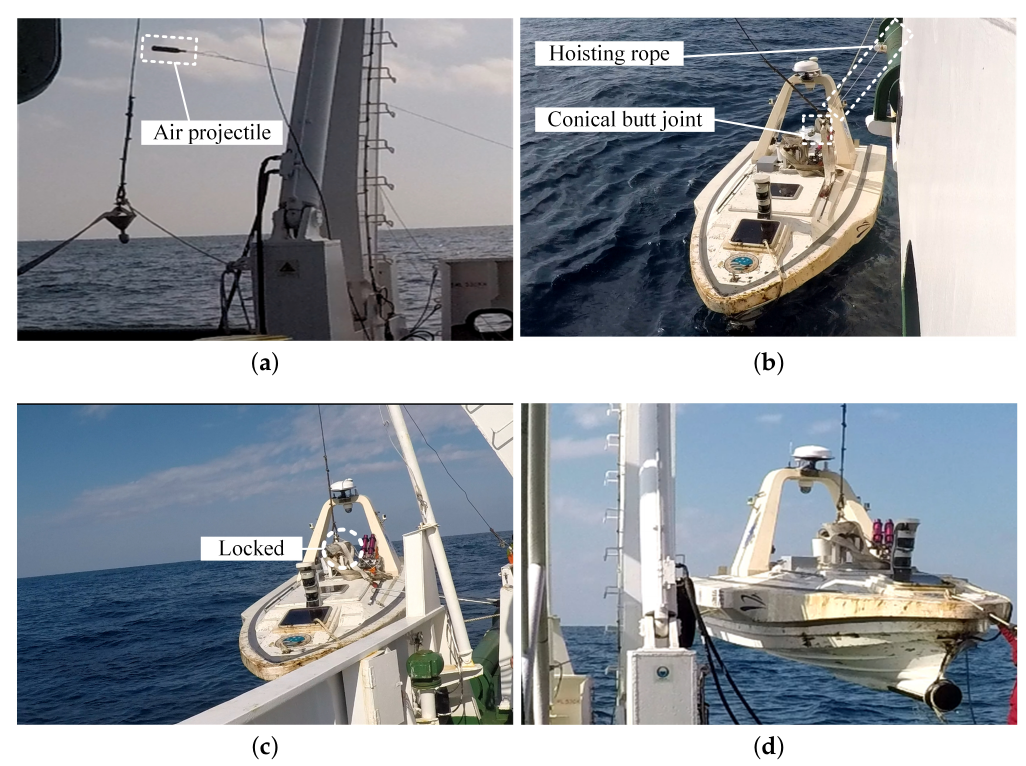
Figure 10. From ( a – d ), recovery process in field application. The recovery process took approximately 23 min. The efficiency of the aiming and launching of L&RS is